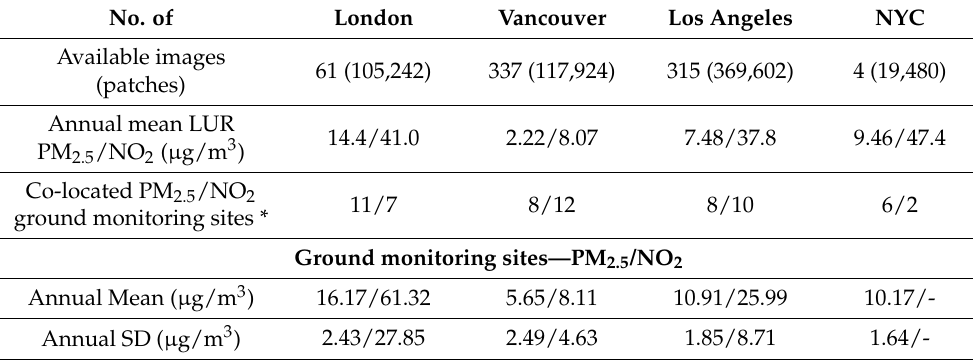
Table 1. Summary details of data availability over the study areas (2010). No. of London Vancouver Los Angeles NYC Available images 61 (105,242) 337 (117,924) 315 (369,602) 4 (19,480) (patches) Annual mean